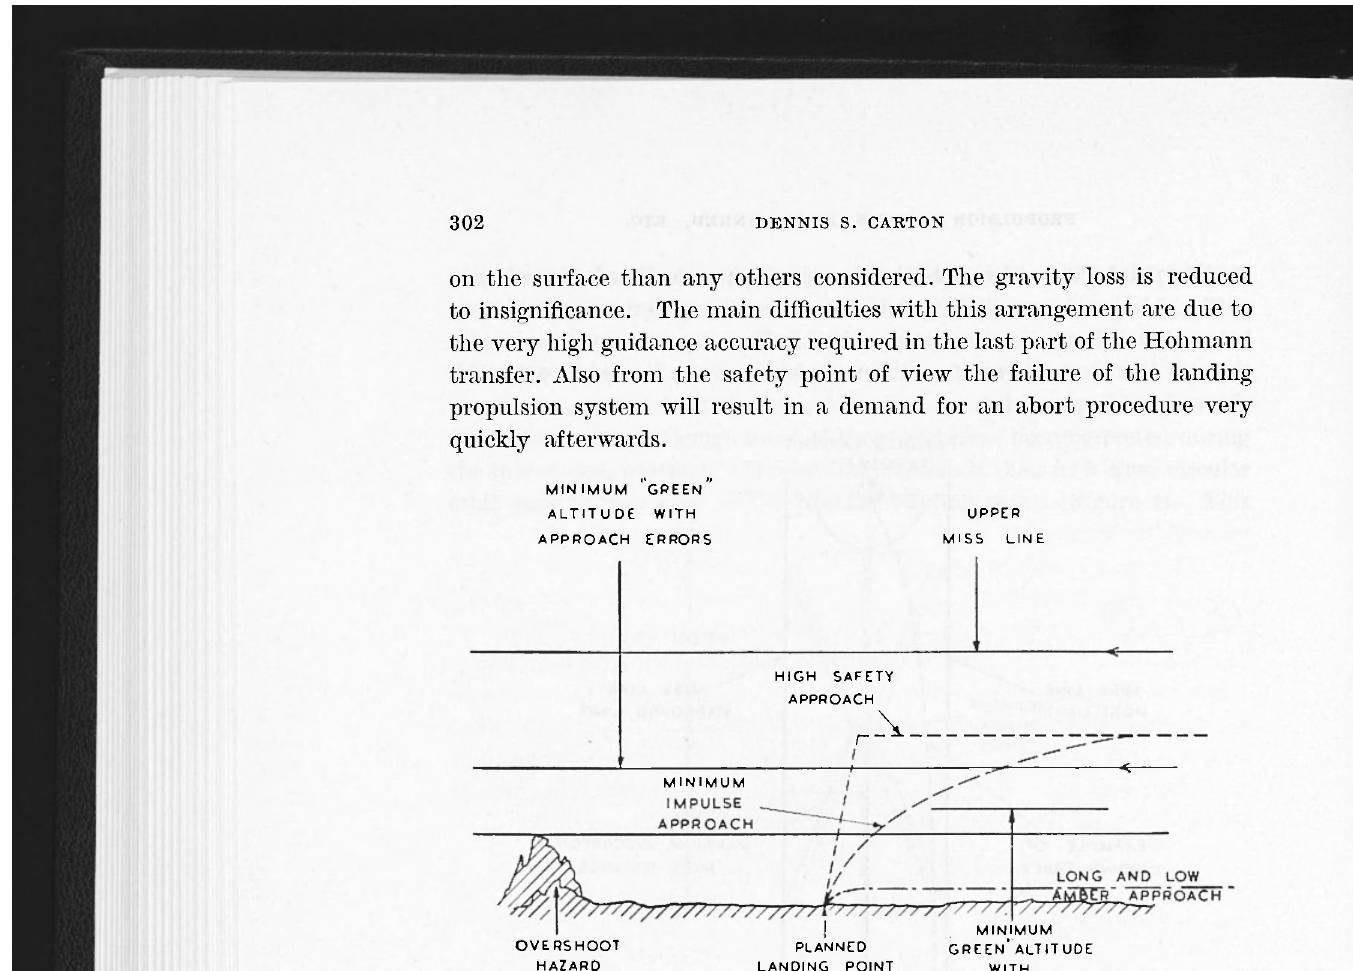
Fig. 6 - Lunar landing corridor side